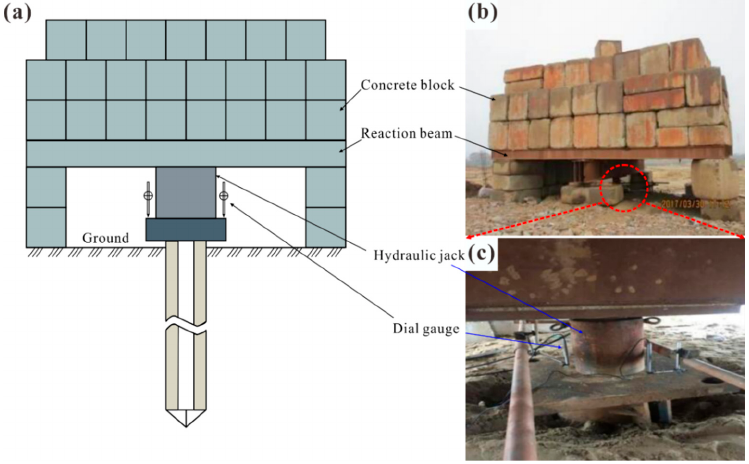
Figure 5. Schematic of static load test. ( a ) Schematic of static load test; ( b ) photograph of static load test in the test; ( c ) hydraulic jack and dial gauge in the